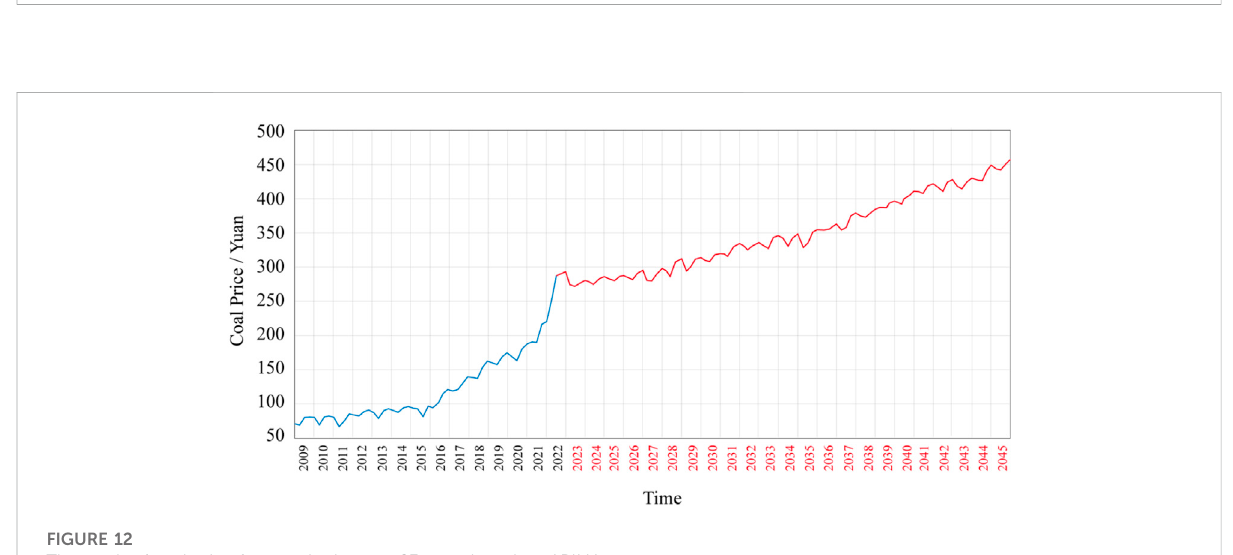
FIGURE 12 The result of coal price forecast in the next 23 years based on ARIMA.